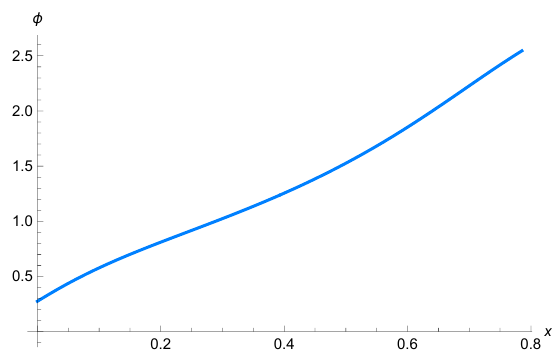
Figure 4 . The behavior of the physical dilaton φ ( x ) , we choose the parameters γ = 2 , λ = 4 and c = 1 .